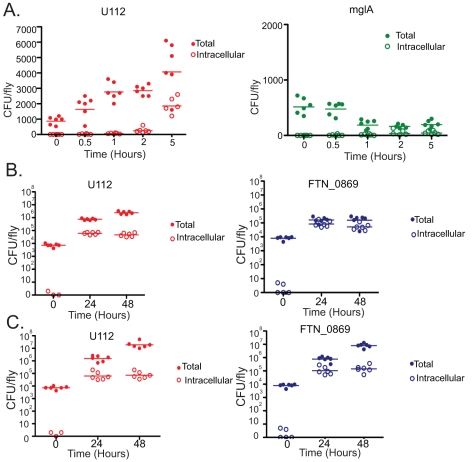

F. novicida mglA mutants are unable to survive intracellularly, while FTN_0869 mutants are unable to survive extracellularly.(A) OR flies were treated with gentamycin at 0, 0.5, 1, 2, and 5 hours post infection after incubation at 29°C. Total CFUs per fly and intracellular CFUs as determined following gentamycin treatment for U112 and mglA mutant bacteria. U112 infected flies are represented on the left in red, mglA infection on the right in green. By 30 minutes post infection 1.5% of U122 CFUs are intracellular, at 1 hour post infection this has increased to 2.3%, by 2 hours 9.6% of the bacteria are intracellular, and by 5 hours, 43.4% of U112 is intracellular. In contrast, none of the mglA mutant bacteria is intracellular is intracellular at any timepoint. Horizontal lines represent the mean of all of the data points. (B) Total CFUs in OR wild-type flies and intracellular CFUs and 0, 24, and 48 hours for U112 and FTN_0869 mutant bacteria. U112 infections are graphed on the left in red, FTN_0869 mutant infection on the right in blue. At 24 hours post infection, 8.2% of the U112 CFUs are intracellular, and by 48 hours only 2% is intracellular because the extracellular population is increasing while the intracellular population remains steady. In contrast, at 24 hours post infection 54% of FTN_0869 mutant bacteria is intracellular and 30% is still intracellular at 48 hours, due to the extracellular population failing to increase. Horizontal lines represent the mean. (C) Total CFUs in imd mutant flies and intracellular CFUs and 0, 24, and 48 hours for U112 and FTN_0869 mutant bacteria. U112 infections are graphed on the left in red, FTN_0869 mutant infection on the right in blue. At 24 hours post-infection the percentages of intracellular U112 bacteria in imd flies is similar to those seen in wild-type flies, with 4.6% and 0.4% intracellular at 24 and 48 hours respectively. However, in imd flies the extracellular population of FTN_0868 mutant bacteria is rescued such that only only 15% of the CFUs are intracellular at 24 hours and only 2% is intracellular at 48 hours post-infection. Horizontal lines represent the mean.